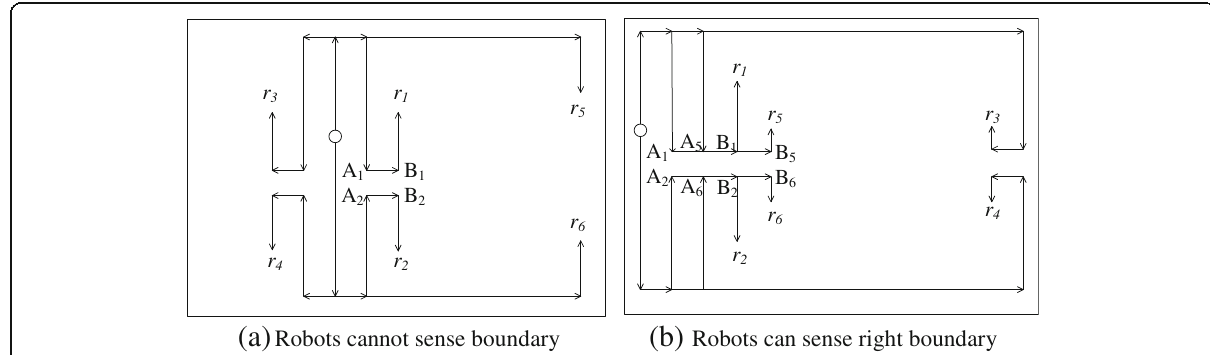
Fig. 2 Initialization for exploration discourse of another multi-robot system ( n =6); all characters in the figure have the same meanings as in Fig.